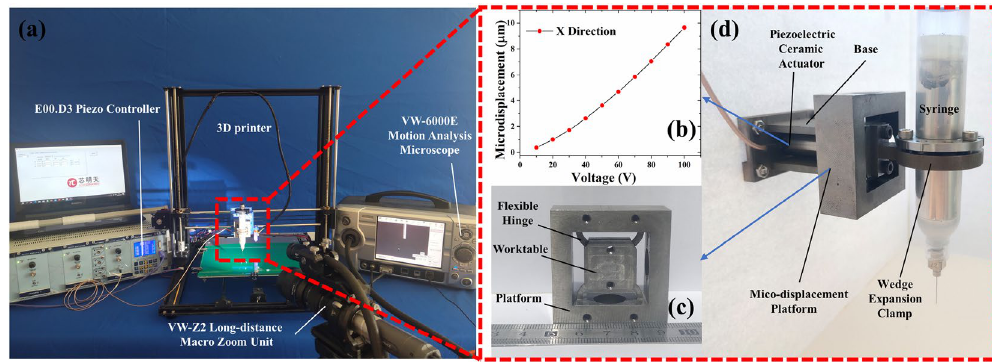
Figure 2. Experimental equipment. ( a ) Composition of experimental system. ( b ) The relationship between voltage and output displacement. ( c ) Micro-displacement platform. ( d ) Micro-vibration